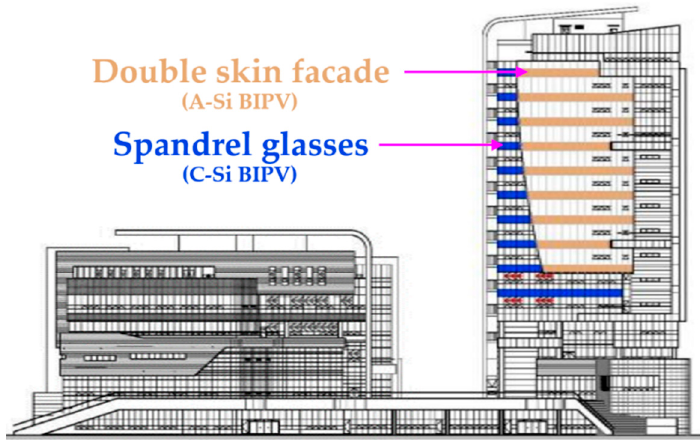
Figure 2. Southern elevation of the main building and installation location of the target C-Si BIPV modules.